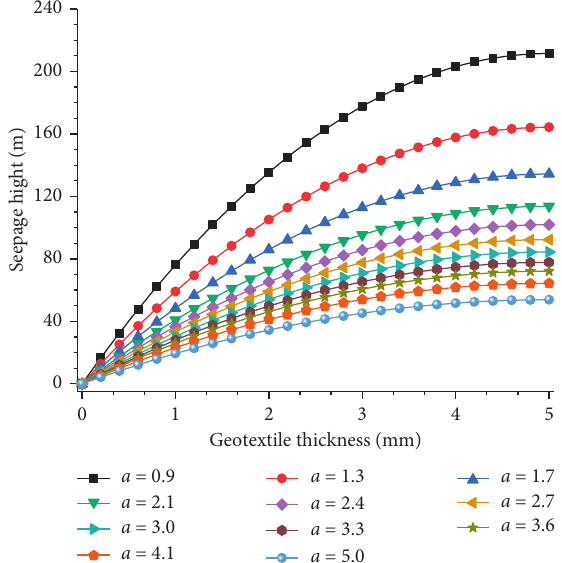
Figure 10: Relationship between the geotextile thickness and the seepage